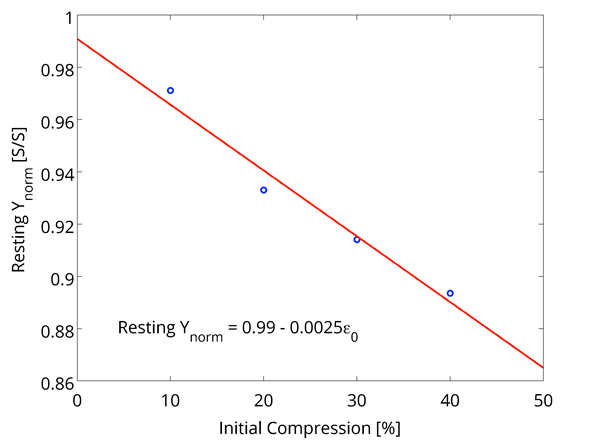
Fig. 11. Resting admittance (normalized) as a function of strain. This relationship was necessary for the admittance relaxation curve proposed in Eq. (12).